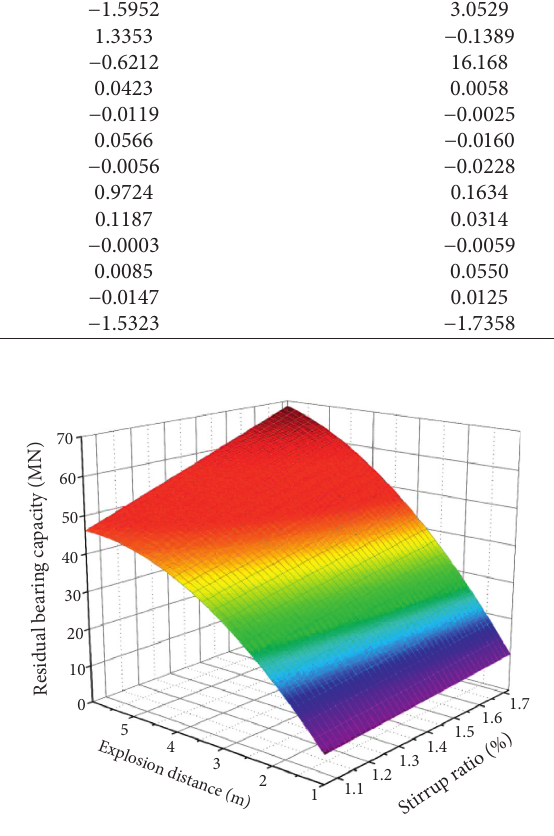
Figure 14: Response surface of pier’s residual bearing capacity under 1# car bomb.